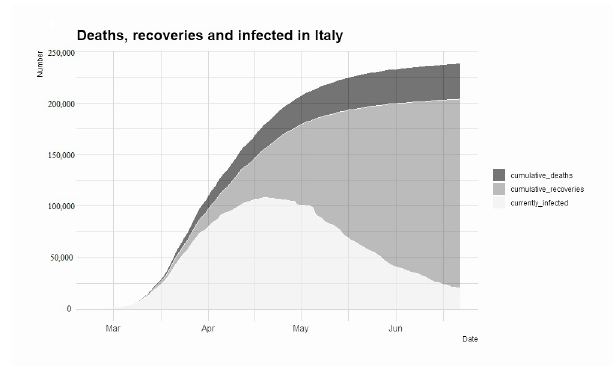
Figure 2. Cumulative number of infections, recoveries and deaths in